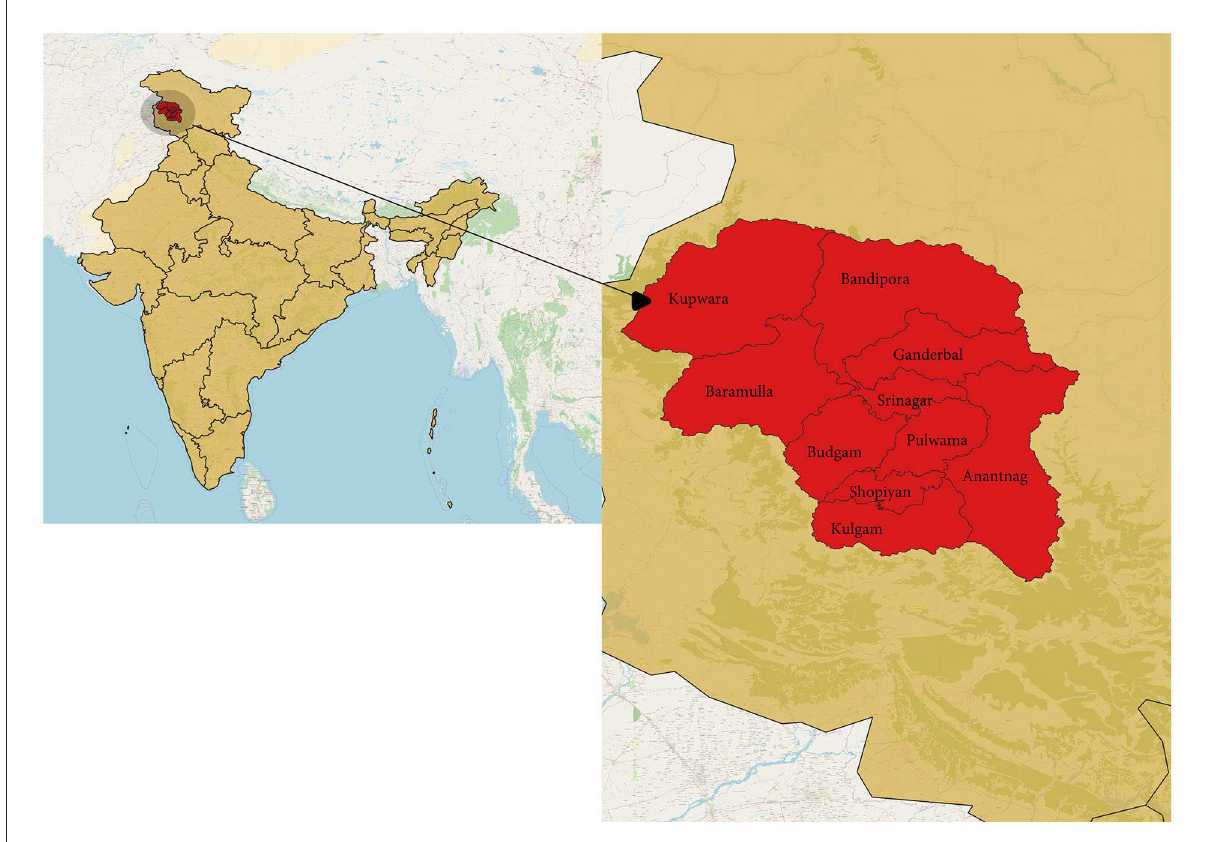
FIGURE1 The study area in the context of the global